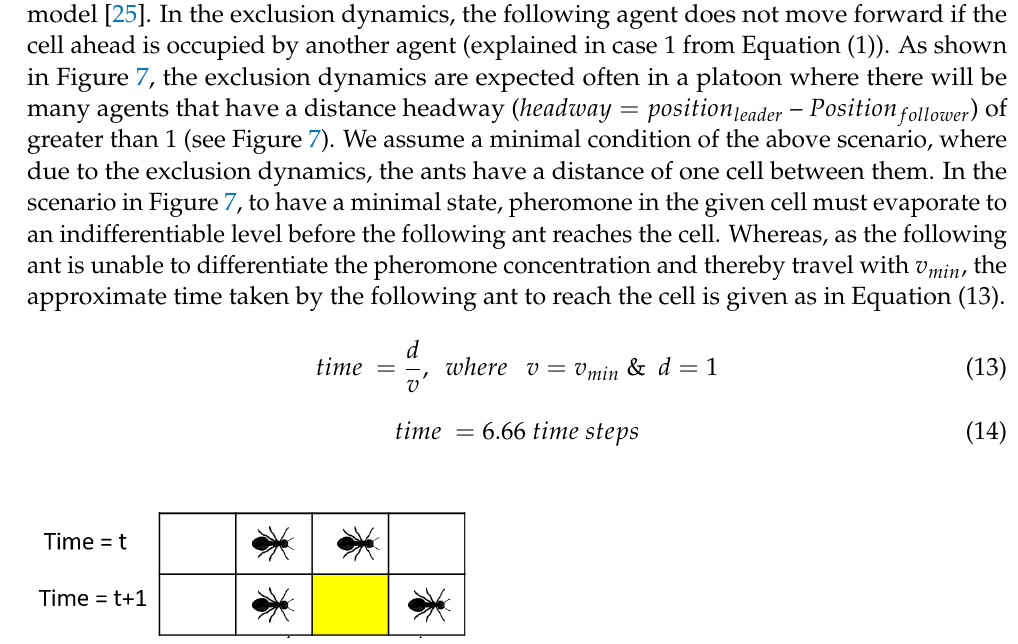
Figure 7. Schematic representation of the exclusion dynamics, which leads to creation of distance headway between adjoining ants from the same platoon in a single time step. In the diagram, the yellow cell represents the cell separating the rare end of the leading ant and the front end of the following